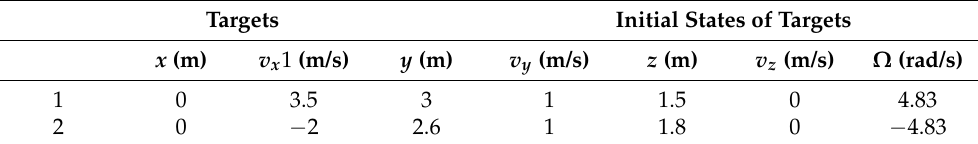
Figure 3. The radar and target geometry for Scenario 1. Table 1. Scenario